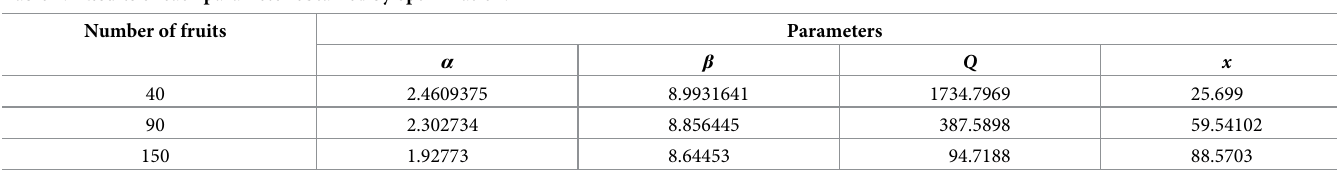
Table 1. Results of each parameter obtained by